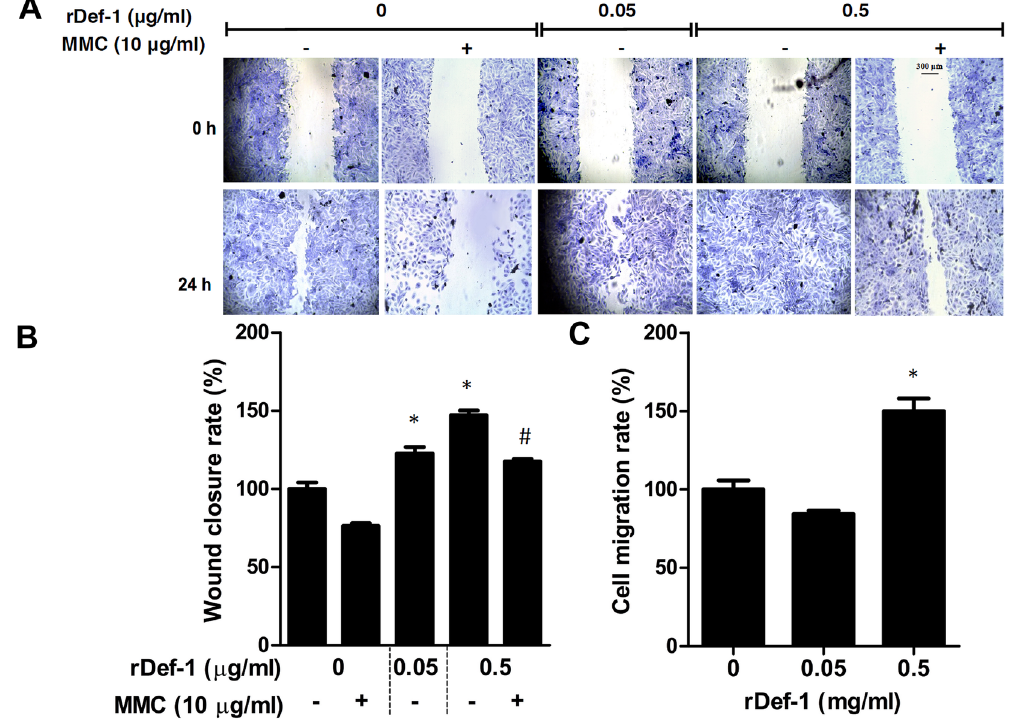
Figure 5. In vitro wound healing properties of a recombinant defensin-1 (rDef-1) in HaCaT cells. Scratch wound analysis was performed with confluent monolayers of HaCaT cells. ( A , B ) Wounded cells were treated either with rDef-1 at two concentrations (0.05 and 0.5 µ g/ml) or with rDef-1 at 0.5 µ g/ml after 2 h pre-treatment with mitomycin C, for 24 h. Wound closure rate was determined as the difference between wound width at 0 and 24 h. Symbol “#” indicate a significant difference from the rDef-1 group without mitomycin C, # P < 0.001. ( D ) HaCaT cell migration was evaluated by the transwell assay plate (8 μ m pore size, ThinCert ™ 24 Well Cell Culture Inserts), where the cells were treated with rDef-1 at two concentrations (0.05 and 0.5 µ g/ml) for 24 h. Data are expressed as means and SEMs of three independent measurements. Asterisks indicate a significant difference from the untreated group, * P < 0.001. Scale bar = 300 μ